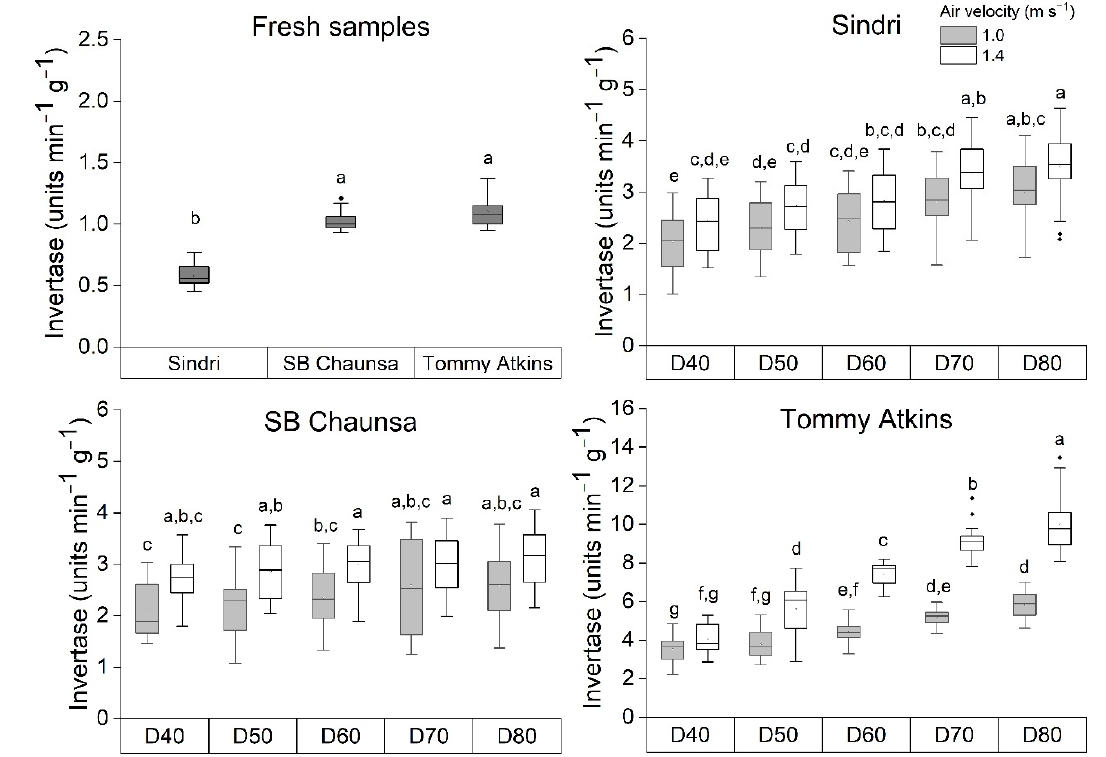
Figure 2. Invertase activity in fresh and dried mango varieties Sindri, SB Chaunsa, and Tommy Atkins; D = dried samples at temperatures 40 °C to 80 °C. a–g, different letters in the box plot indicate significant differences under the limit of p < 0.05, ( n = 20 × 3).